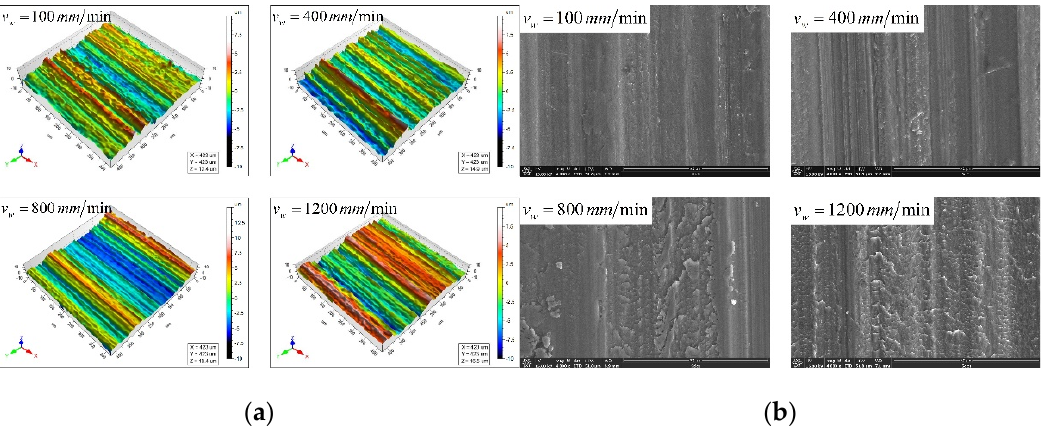
Grinding wheel linear speeds: 600 mm/min).